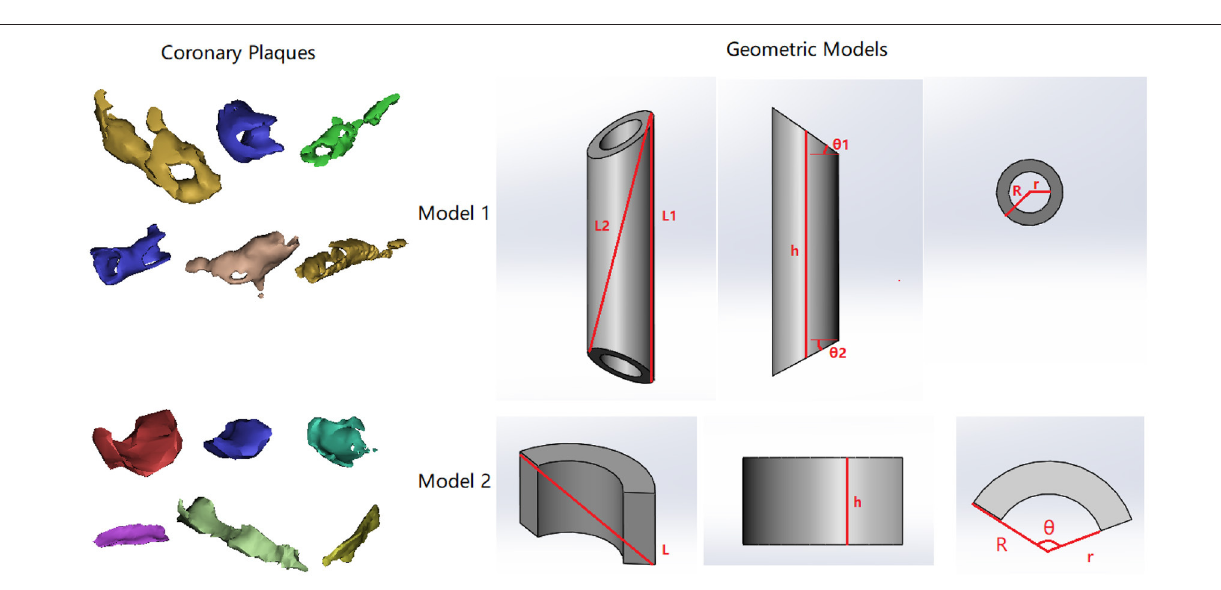
FIGURE 6 | Two types of coronary atherosclerotic plaques and corresponding geometric models. In both models, R, r, and h are the external radius, internal radius, and height on the centerline. In model 1, L 1 describes the longest segment along the longitudinal direction on the surface. L 2 describes the segment from one end of L 1 to the opposite side. L 1 and L 2 form a plane across the centerline of the cylinder. θ 1 and θ 2 describe the dihedral angles between slanted surface planes and the perpendicular cross-section plane at both ends. In model 2, θ describes the circumferential range of the partial